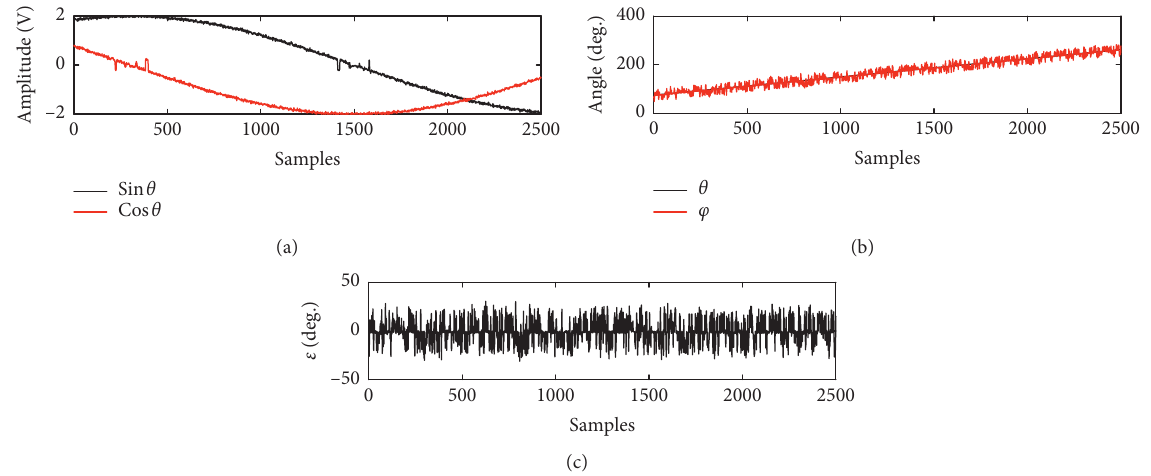
Figure 5: Simulation results without the filter. (a) Demodulation signals. (b) Rotor angle. (c) Angle error.